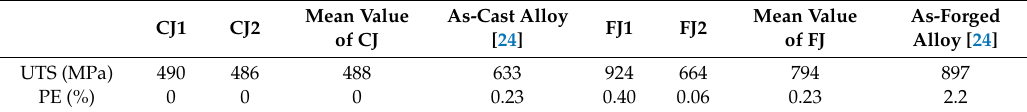
Figure 13. Force-displacement curves of the tensile specimens. Table 2. Tensile properties of the specimens and the PMs.